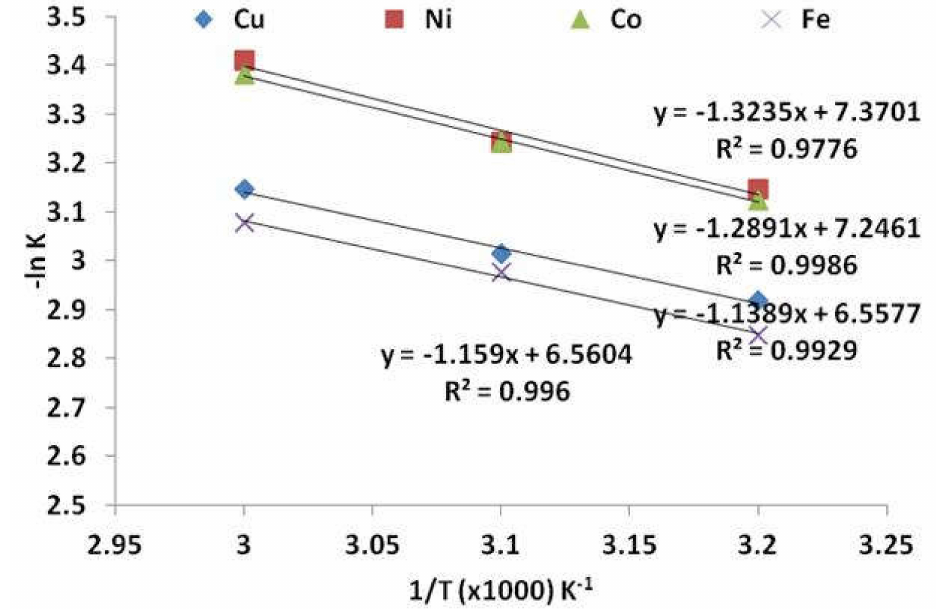
Figure 14. Arrhenius plot for chemical-controlled leaching of Cu, Ni, Co, and Fe from converter slag using 2 N citric acid in temperature range (308–328 K).